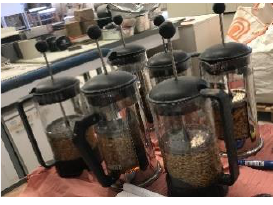
Figure 4. Experimental method for measuring water absorption.